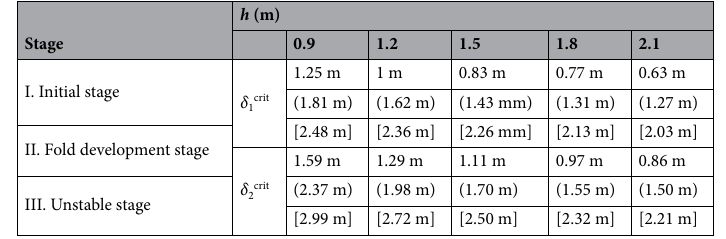
Table 5. δ crit under different fault types and h. a ( b ) [ c ]. a , b , c are δ crit under the oblique-reverse, strike-slip and reverse fault displacement,